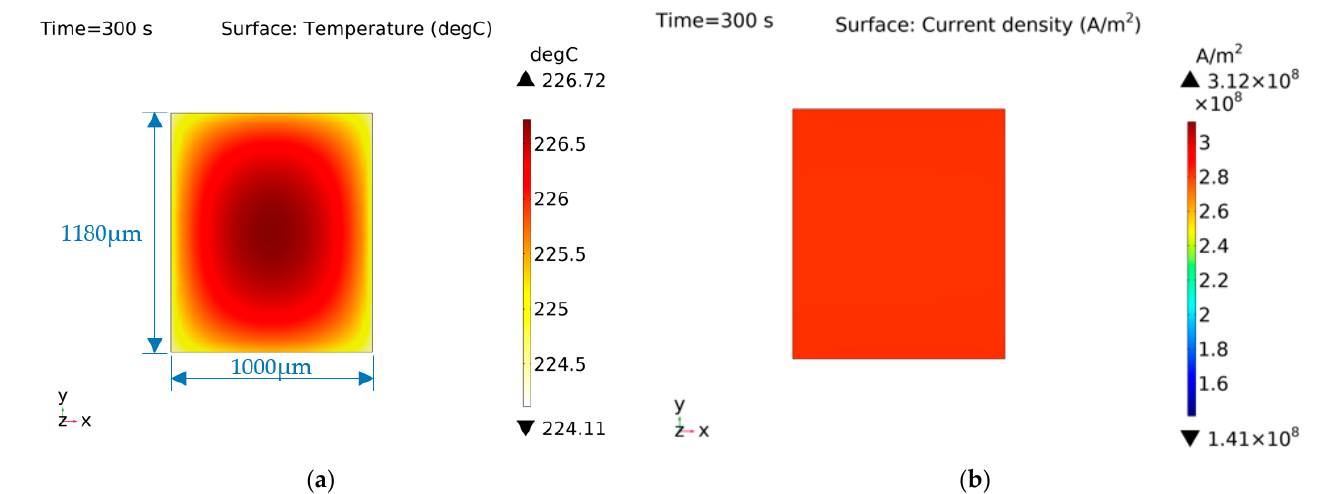
Figure 15. Characteristic distribution of shape A with a constant current (1 A) excitation. ( a ) Tem- perature distribution; ( b ) Current density distribution.